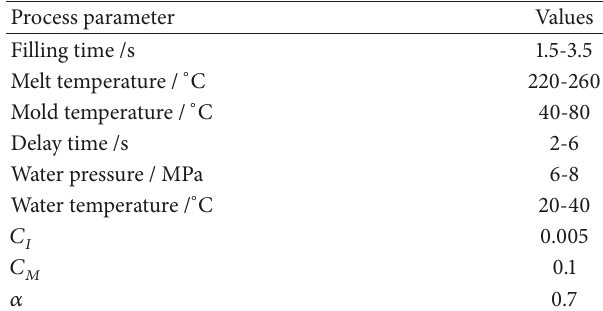
Table 1: Related process parameters in